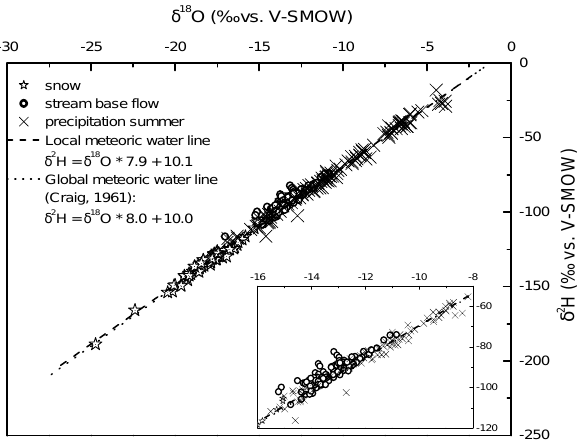
1117 Figure 4: δ 18 O vs. δ 2 H (of H 2 O) in precipitation and stream water base flow. 1118 1119 Fig. 3. δ 18 O vs. δ 2 H (of H 2 O) in precipitation and stream water 1120 base